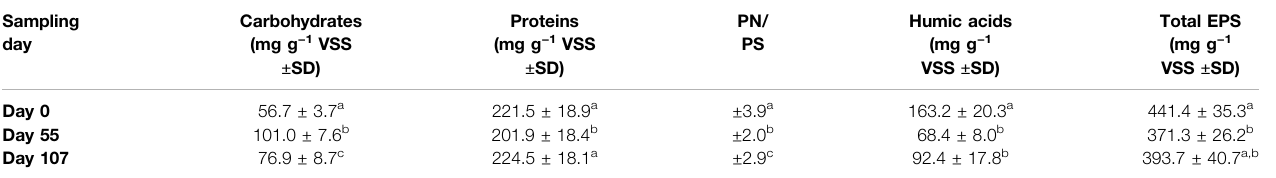
TABLE 2 | Biochemical characterization of the EPS extracted from the AGS biomass (average value ± standard deviation). Sampling day